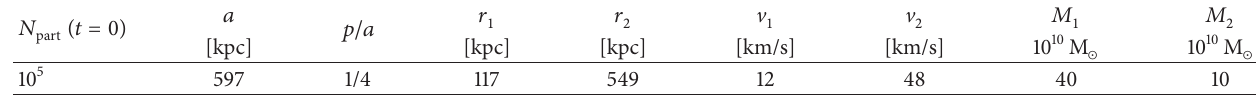
Table 2: Input parameters of SPH simulation of UGC